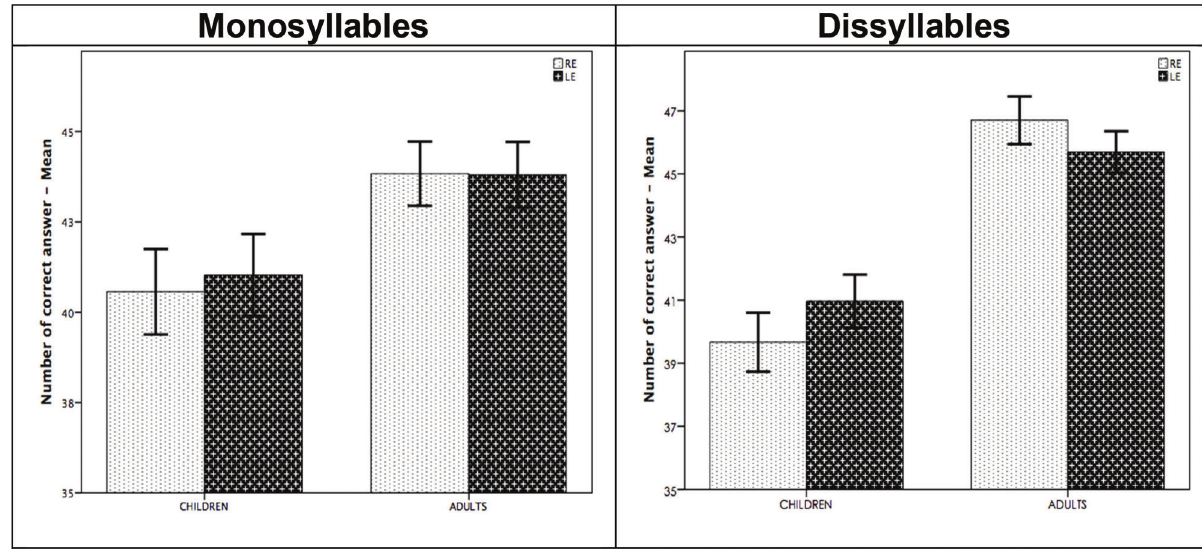
Figure 1 - Mean performance obtained between right and left ears without TCS in children and adults